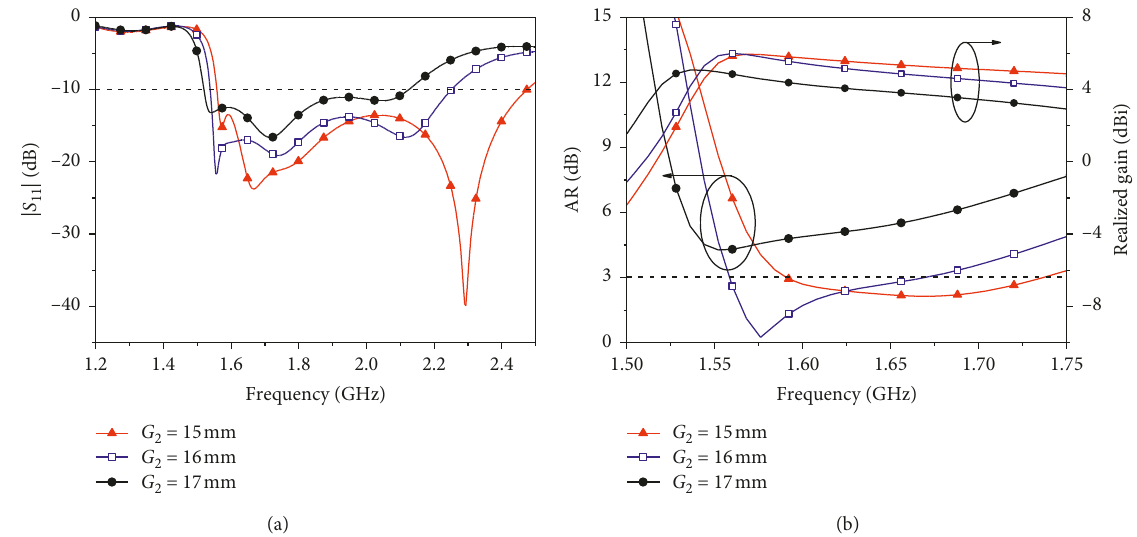
Figure 7: Variations of (a) | S 11 | and (b) AR and realized gain with different dimensions of the inner square patches, G 2 .